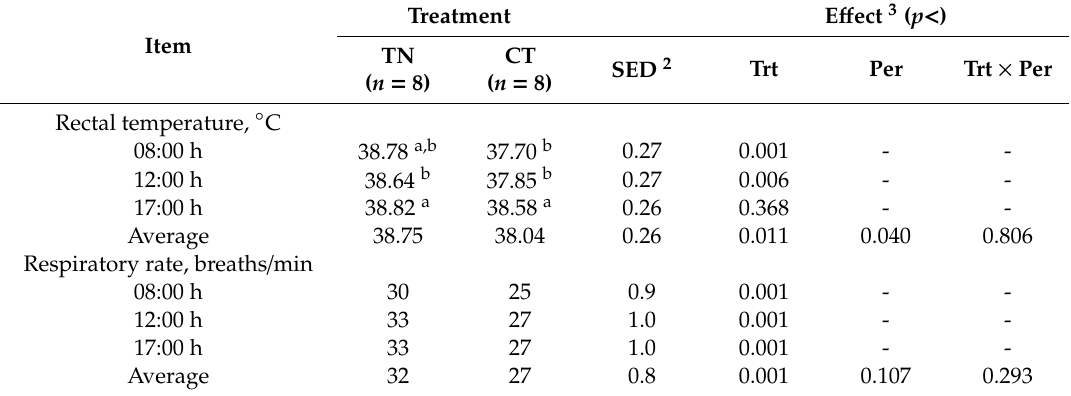
Table 2. Rectal temperature and respiratory rate measured at 8:00 a.m., 12:00 p.m., and 5:00 p.m. in dairy goats under thermoneutral (TN, 15 to 20 ◦ C) or cold temperature (CT, − 3 to 6 ◦ C) conditions 1 .